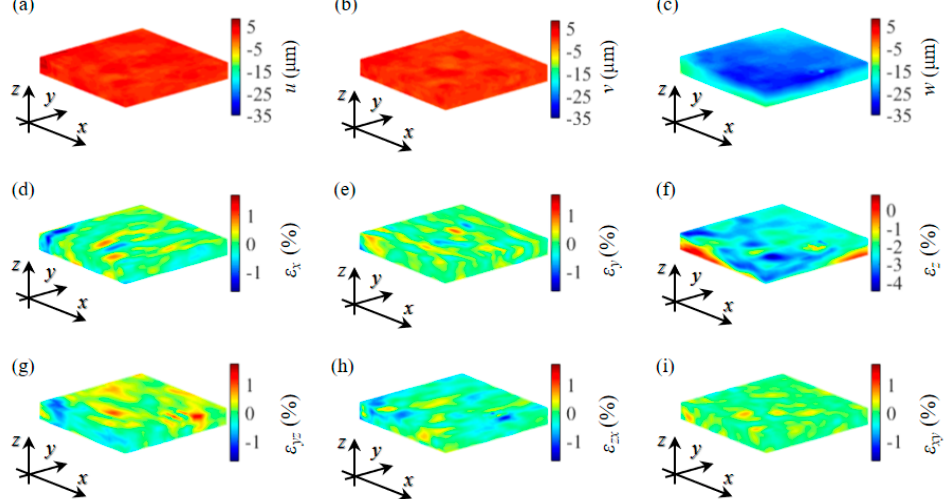
Figure 9. 3D deformation measurement of a pork specimen. ( a – c ) 3D displacements in the x , y and z directions respectively; ( d – f ) 3D normal strains in the x , y and z directions respectively; ( g – i ) 3D shear strains.